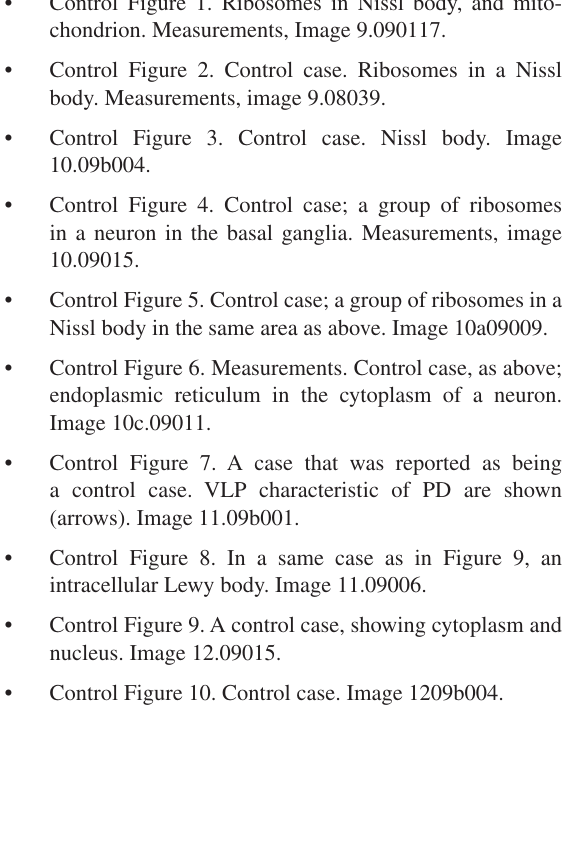
Control Figure 11. Control case. Image 1209b015. Control Figure 12. Control ribosomes, measurements. Image